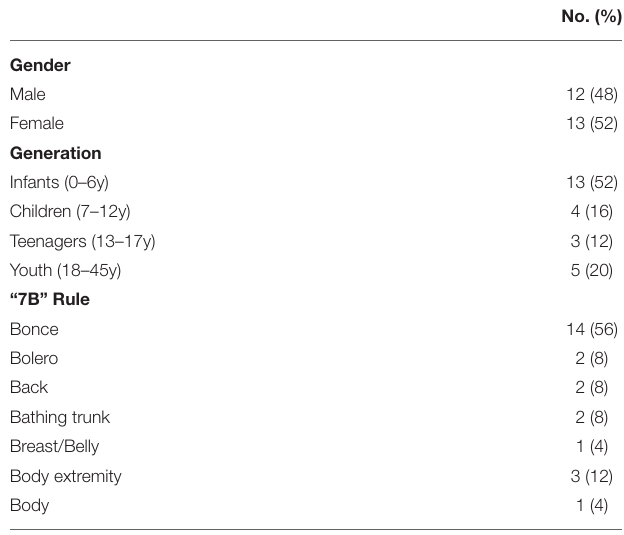
TABLE 2 | Clinical characteristics of patients with LCMN.